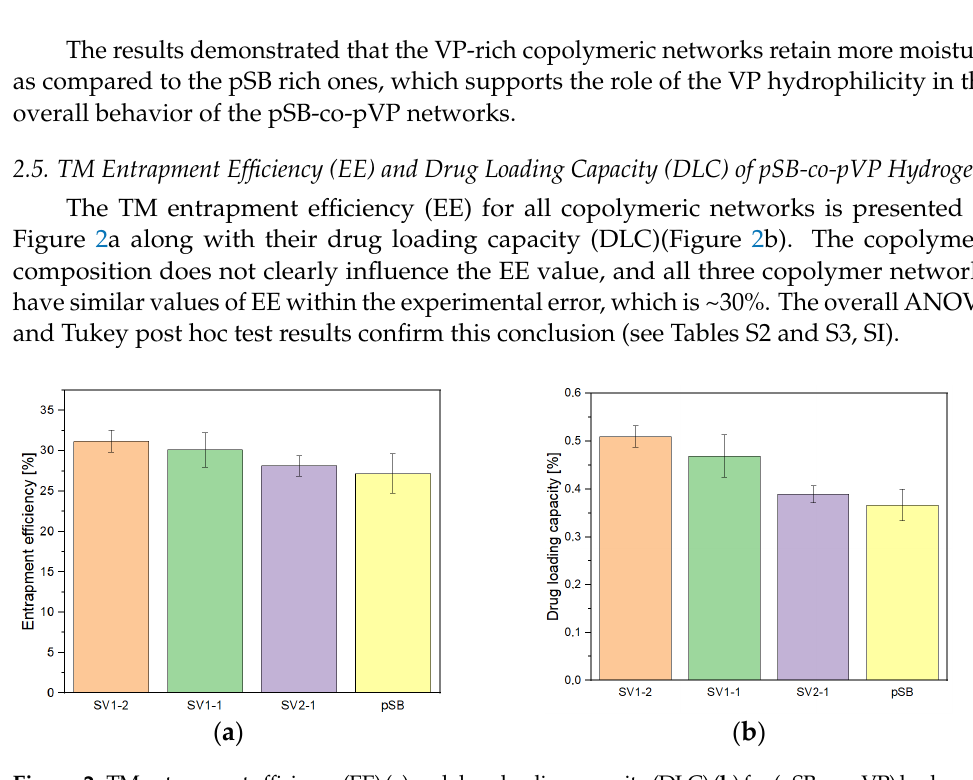
Figure 2. TM entrapment efficiency (EE) ( a ) and drug loading capacity (DLC) ( b ) for (pSB-co-pVP)